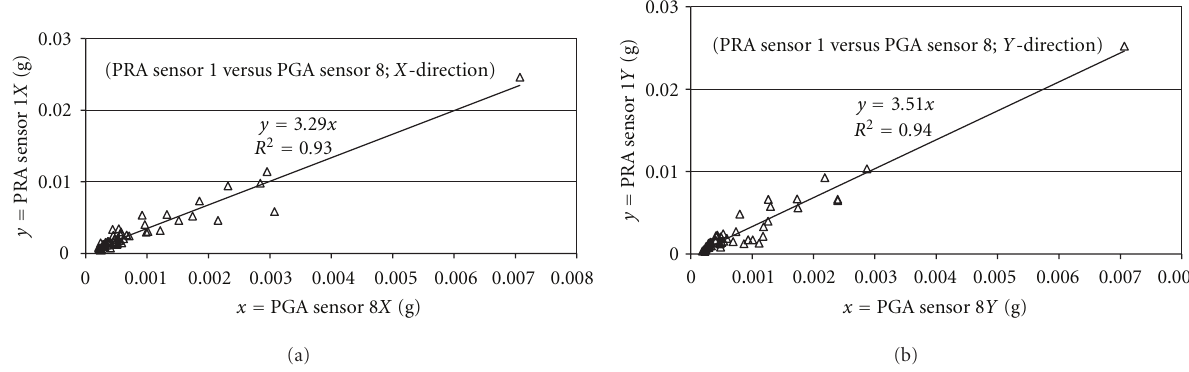
Figure 8: PRA of building B recorded by sensor 1 versus PGA at base recorded by sensor 8: (a) X -direction and (b) Y -direction.